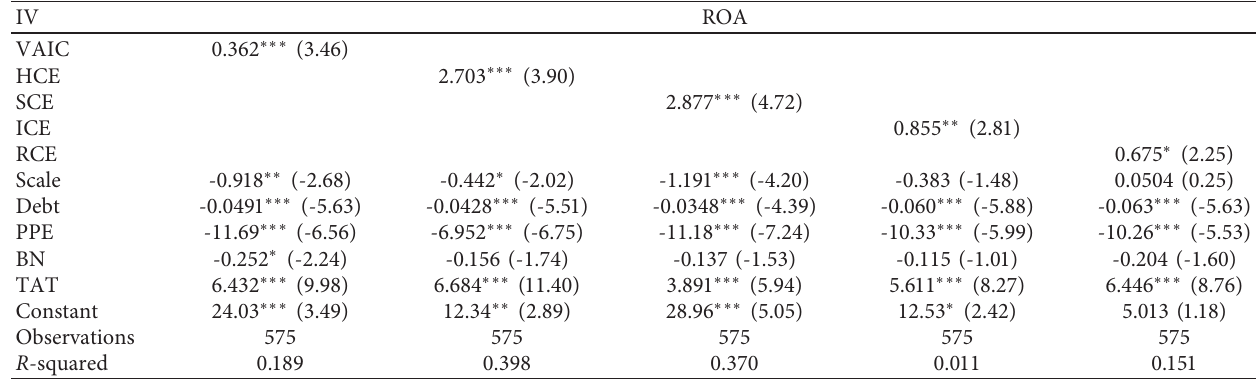
Table 9: Instrumental variables (GMM) regression.